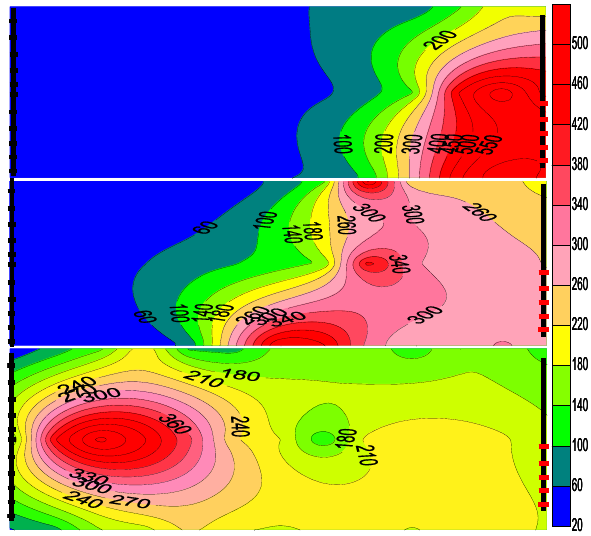
Fig. 7 The combustion front propagation in the model for 20 m pay zones